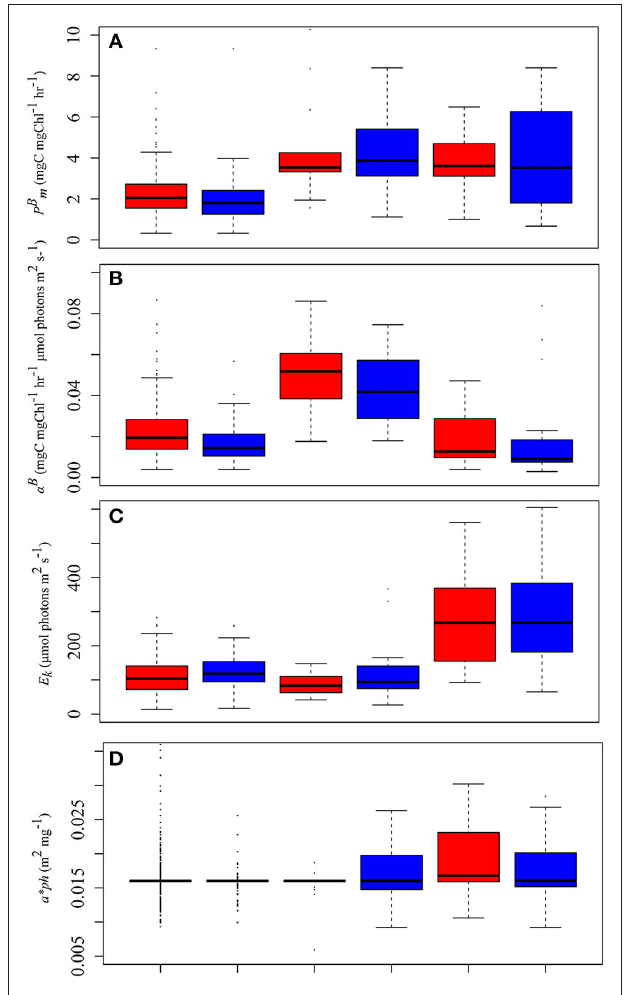
FIGURE 5 | Median PE parameters estimated from Uitz et al. (2008) (red bars) and Sathyendranath et al. (2009) (blue bars) for (A) P B m [mg C (mg Chl a ) − 1 h − 1 ], (B) α B , [mg C (mg Chl a ) − 1 h − 1 ( µ mol photons m − 1 s − 1 ) − 1 ], (C) E k ( µ mol photons m 2 s − 1 ), and (D) a ph * (m 2 mg − 1 ) for the three